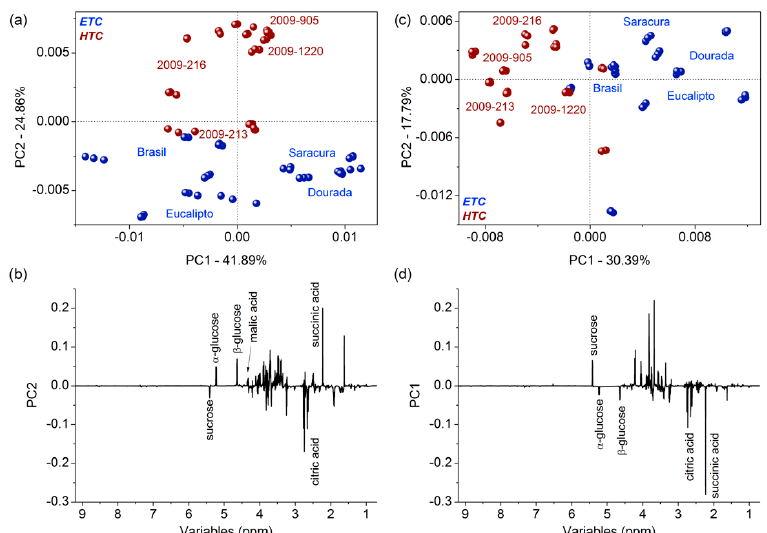
Figure 3. Scores coordinate system (PC1 × PC2) from cassava genotypes harvested nine months after planting ( a ) in blue, and 15 months after planting ( c ) in red. Relevant loadings from cassava genotypes harvested after nine months ( b ) and 15 months ( d ) plotted in lines in the same intensity. HTC genotypes are illustrated as stars, and ETC as circles.